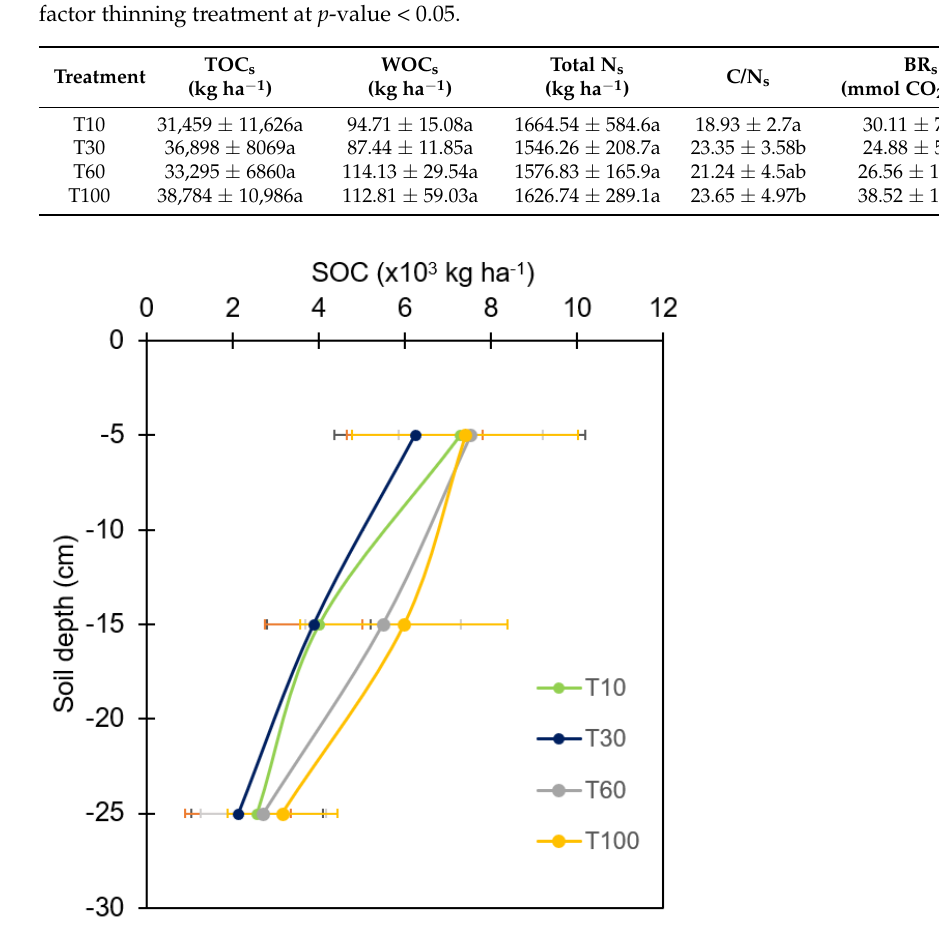
Figure 2. Oxidizable soil organic carbon (SOC, × 10 3 kg ha − 1 ) as a function of soil depth (cm) and thinning intensity treatment. Thinning intensity was a non-significant factor in the ANOVA, while soil depth was significant at p -value <0.05. Lines are drawn to improve the visualization of the SOC profile for each thinning treatment.